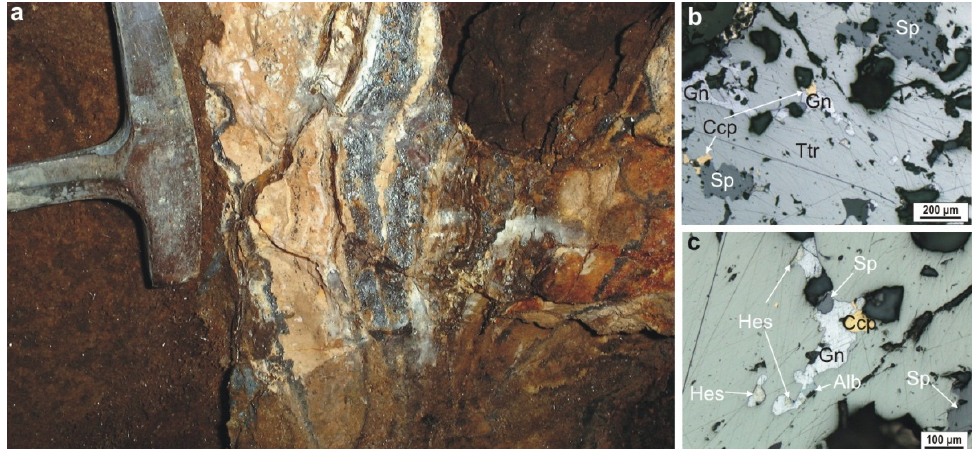
Figure 6. Underground view ( a ), and microphotographs in plane polarized light ( b , c ) of the ore body corresponding to sample 3231, Cârnicel vein, Verche ș mining level: ( a ) detail of the Cârnicel vein depicting the rhodochrosite and ore minerals sequences; ( b ) tetrahedrite dominated sulfide assemblage with sphalerite, galena, and chalcopyrite inclusions; and ( c ) detail of image 6b, showing galena and the associated chalcopyrite, hessite, and alburnite inclusions within the tetrahedrite. Abbreviations: Alb: alburnite; Ccp: chalcopyrite; Gn: galena; Hes: hessite; Sp: sphalerite; and Ttr: tetrahedrite.